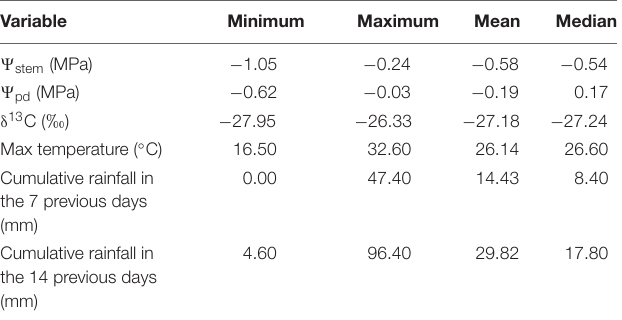
TABLE 2 | Descriptive statistics for grapevine water status and meteorological data.